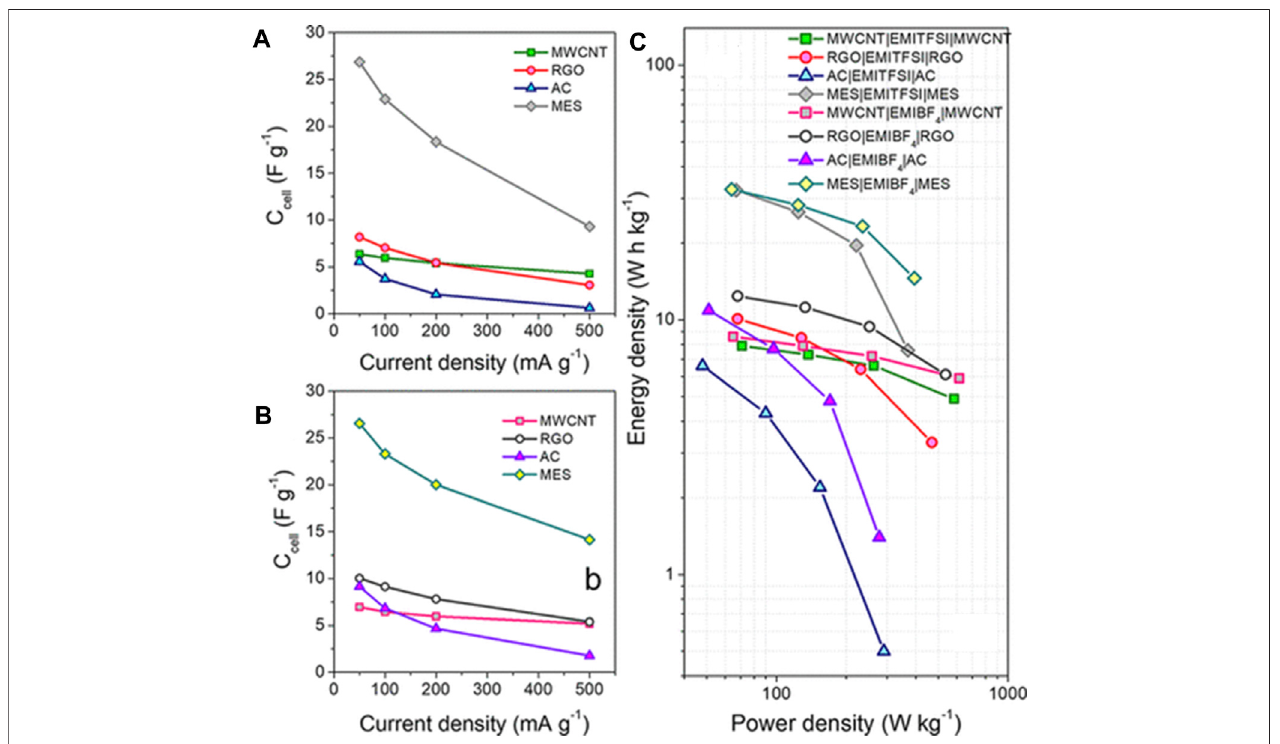
FIGURE3| Speci fi ccapacitance asafunctionofcurrentdensityfortheSCswithdifferentporouscarbonelectrodesandwith (A) (EMIM)(Tf 2 N)and (B) (EMIM)(BF 4 ) as electrolytes. Reprinted with permission from (Ortega et al., 2020), American Chemical Society.